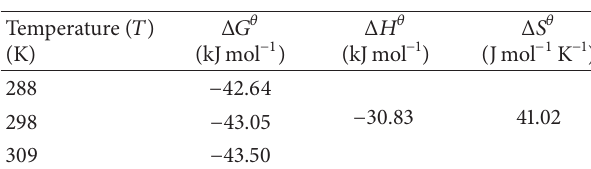
Table 3: Thermodynamic parameters of BSA-ELV